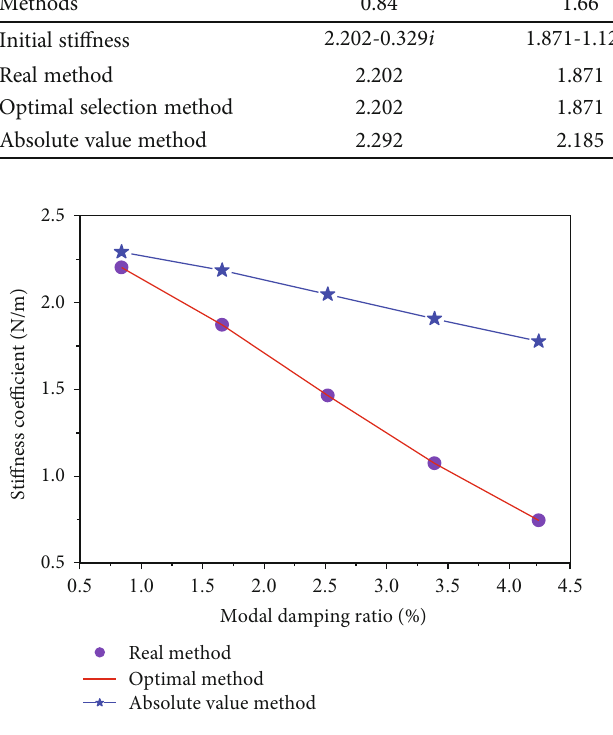
Figure 6: Sti ff ness values under di ff erent modal damping ratios. Table 5: Second frequency and error under di ff erent modal damping ratios.